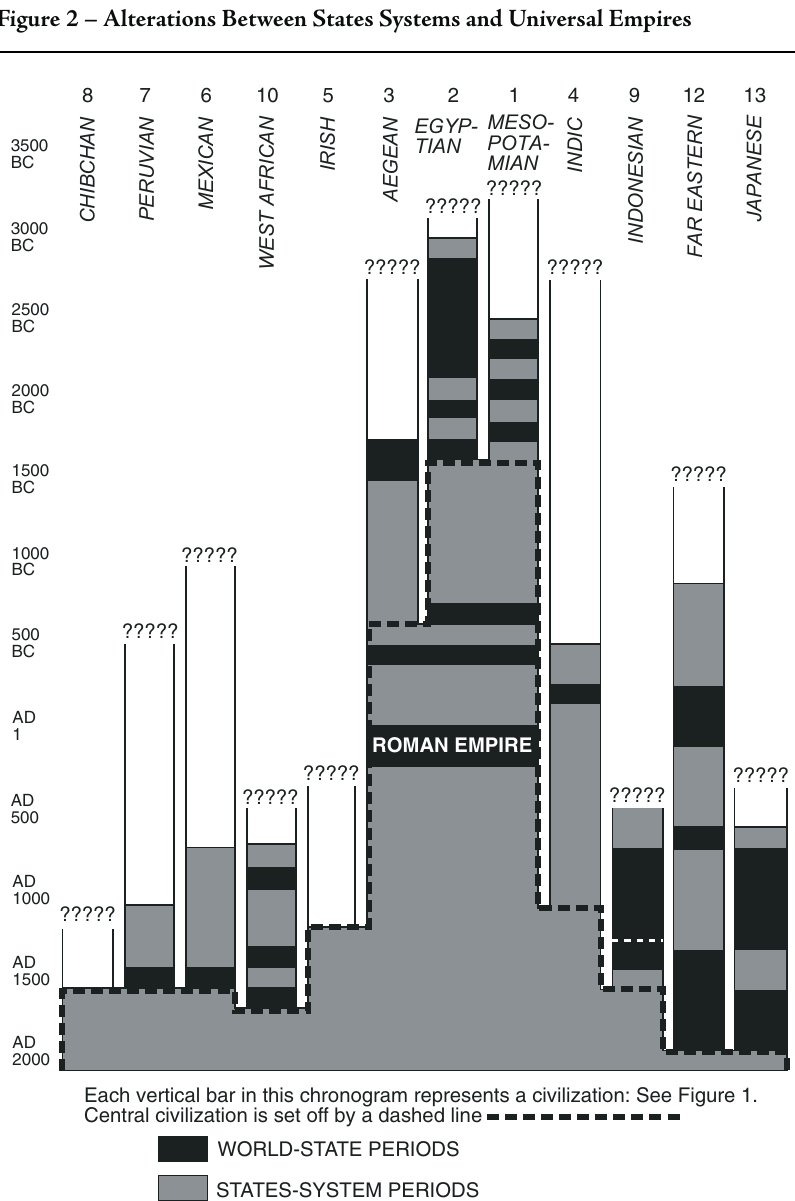
Figure 2 – Alterations Between States Systems and Universal Empires